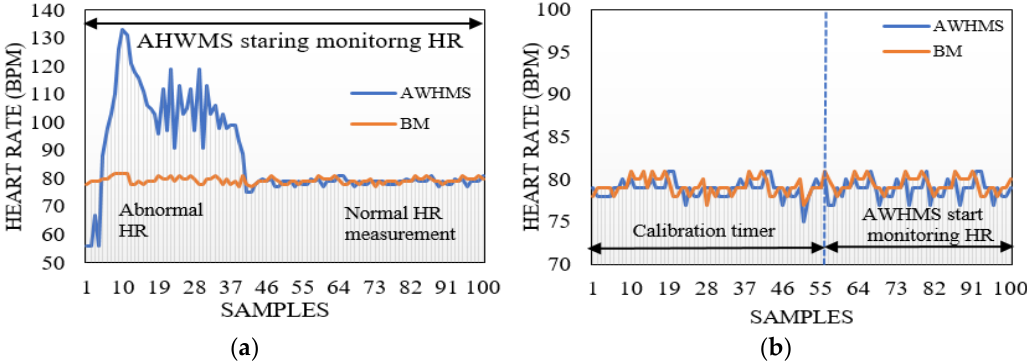
Figure 3. HR settling time ( a ) without the calibration algorithm and ( b ) with the calibration algorithm.